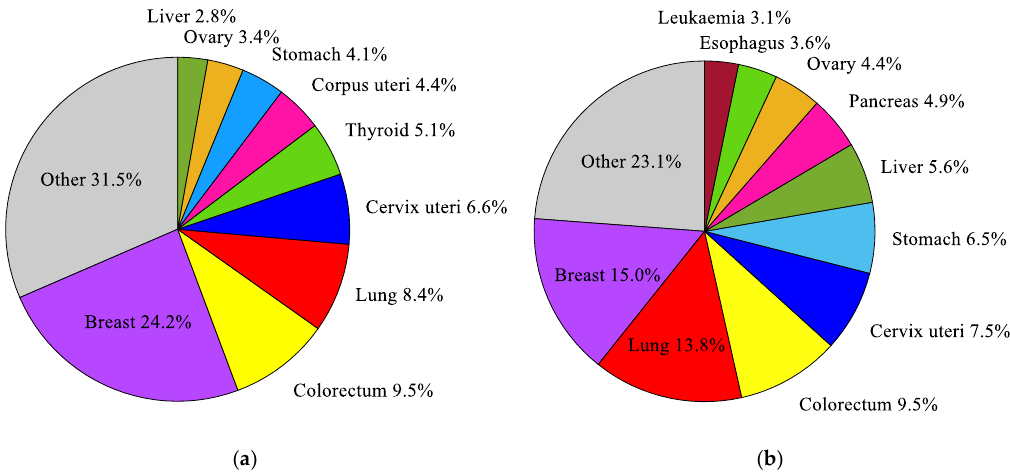
Figure 1. The most common cancers occurring in the world’s female population in 2018: ( a ) incidence; ( b ) mortality, according to the global cancer database GLOBOCAN 2018 [38].